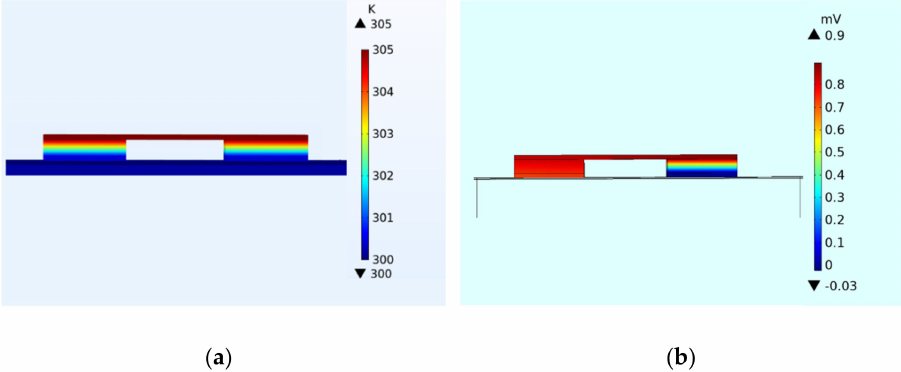
Figure 3. ( a ) Temperature distribution of square-shaped leg pair TEG; ( b ) potential distribution across the device in square-shaped leg pair